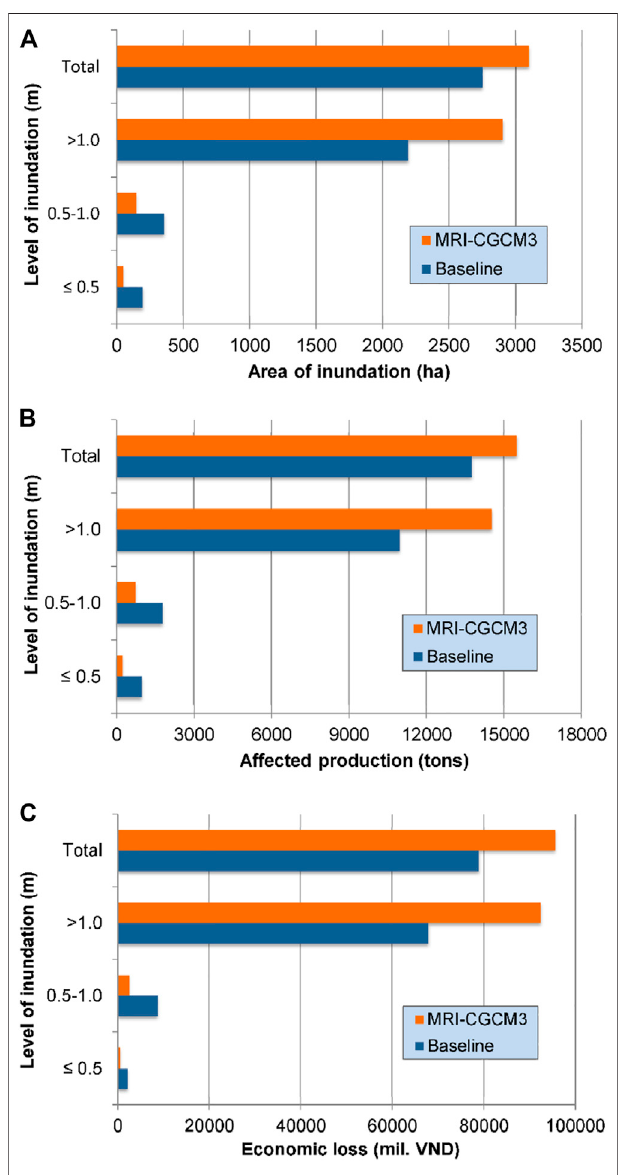
FIGURE 14 | A comparison between the baseline period and 2050s on inundated area (A) , production affected (B) and economic loss of rice production (C)